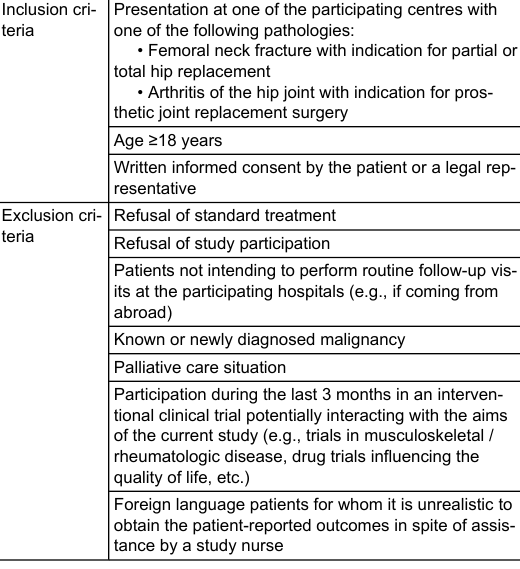
Table 2: Inclusion and exclusion criteria for the MIDAS study. Inclusion cri-